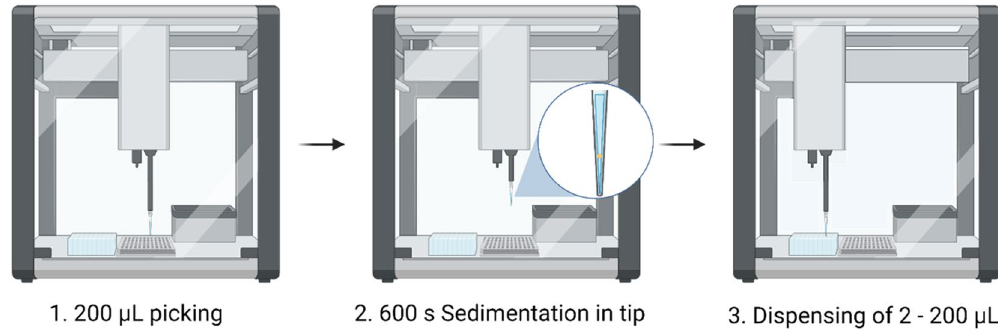
Figure 7. Method development for the transfer of 150–200 µm HepG2 micro-tissues using laboratory automated liquid handler. Created with